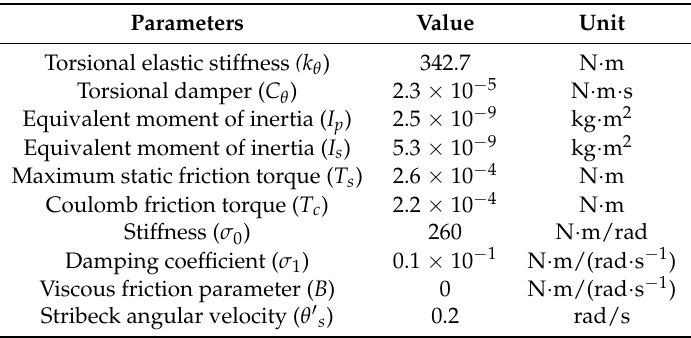
Table 2. Parameters in simulation.